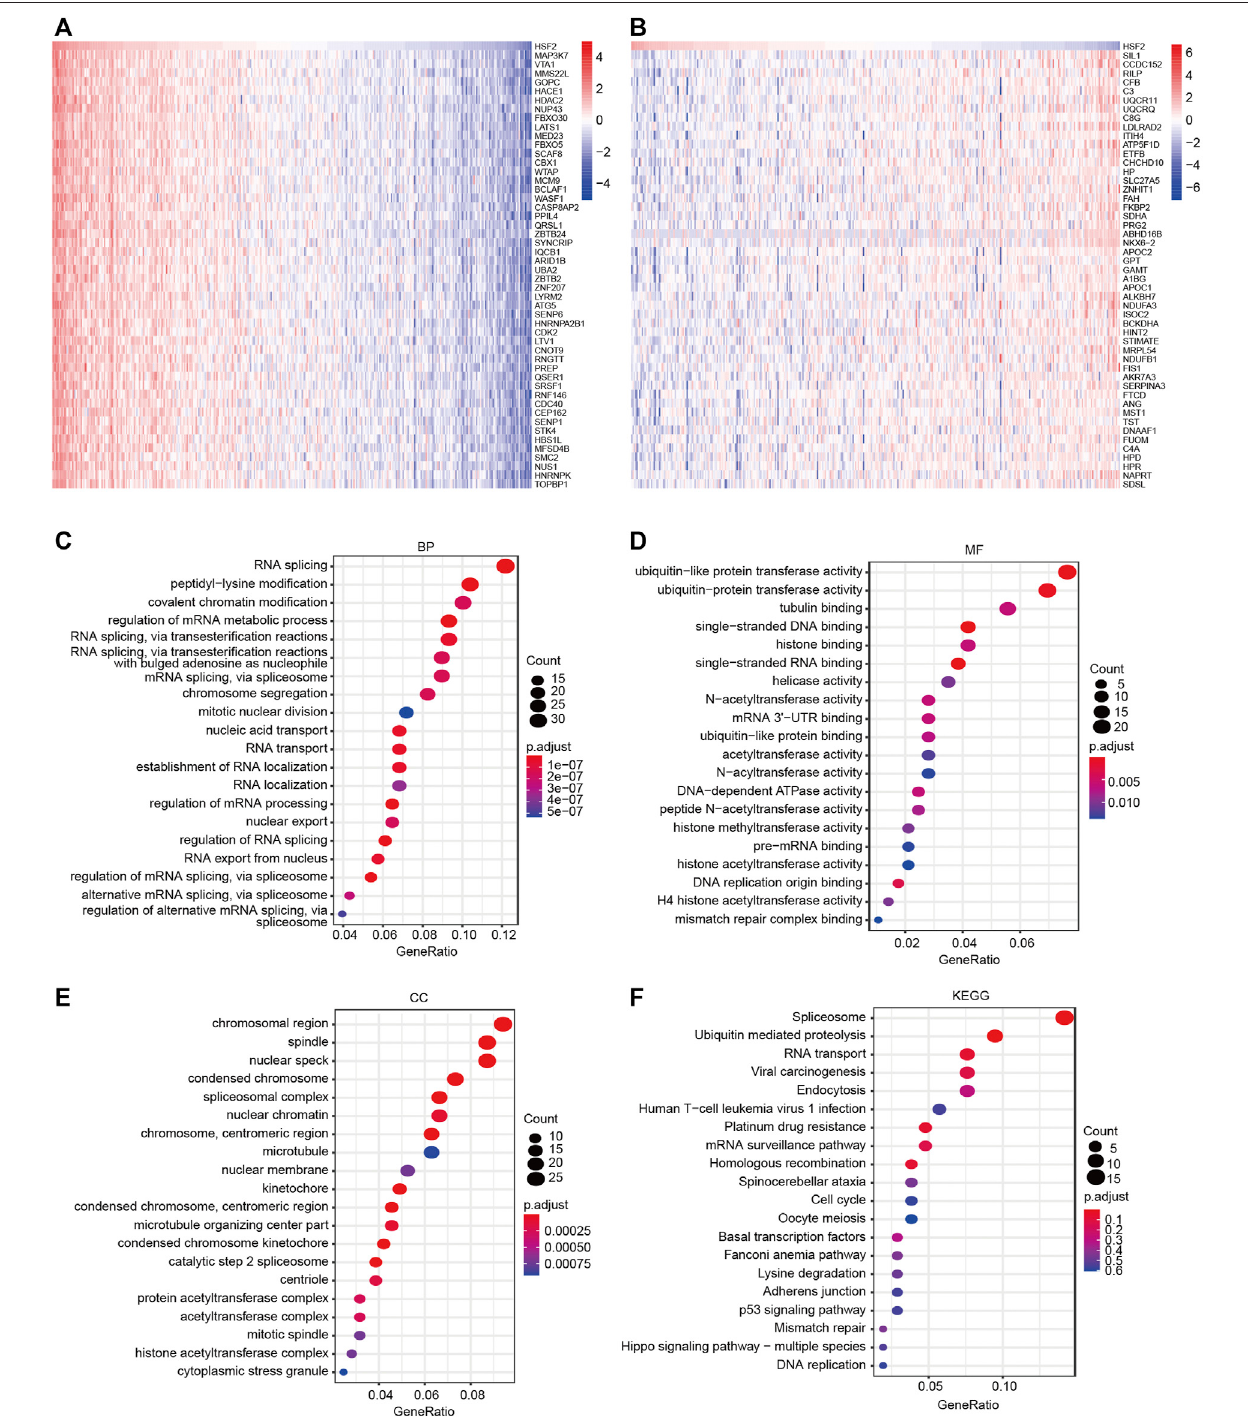
FIGURE 6 | GO and KEGG enrichment analyses of HSF2. (A – B) Heatmaps indicating the top 50 genes positively and negatively correlated with HSF2 in HCC. (C – E) Top 20 enriched terms in the BP, MF and CC categories in HCC. (F) Top 20 pathways enriched in the KEGG analysis of HCC.